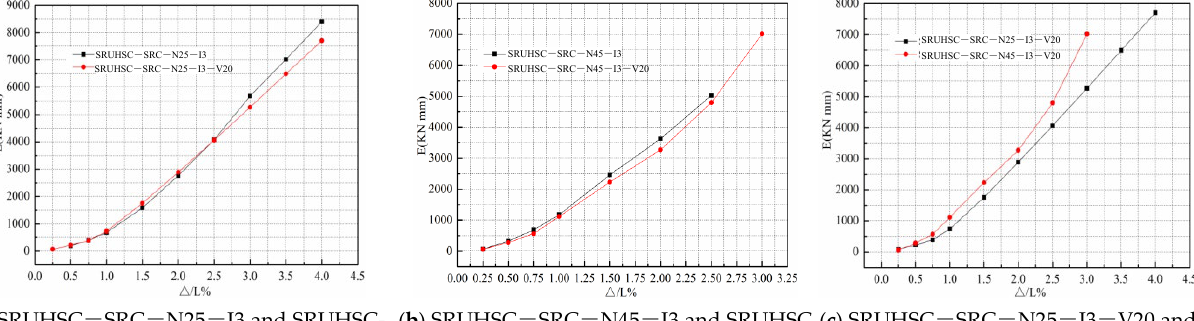
Figure 9. Dissipation capacity of fast loading.